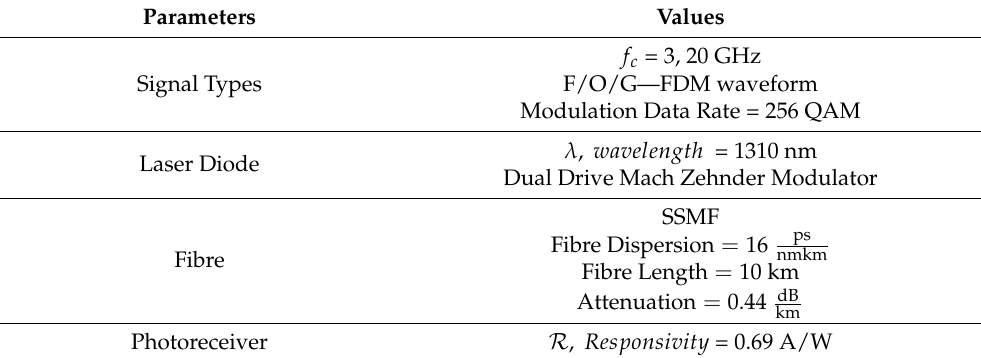
Figure 3. 5G NR fibre–wireless system experimental block schematic. The functions are as follows: A: Selection switch for DPD or direct post-processing for performance evaluation; B: switch selection for synchronisation block or a performance post-processing block. C: B is turned towards synch and connected to train block, while C will be used to synch the DPD trained version. D: Training follows the synchronisation block. DPD: The training is enabled/disabled by DPD. E: The method of time synchronisation (TS) is necessary so that Tx and Rx waveforms are in tight synchronization. F: Required for checking DPD inputs before transmitting to VSGs. CNN has been picked for DPD training. Table 2. Link Parameters.